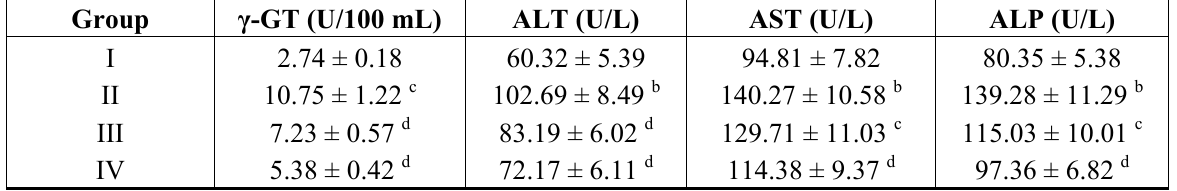
Table 3. Sodium aescinate injection liquid affecting serum γ -GT, ALT, AST and ALP levels. Group γ -GT (U/100